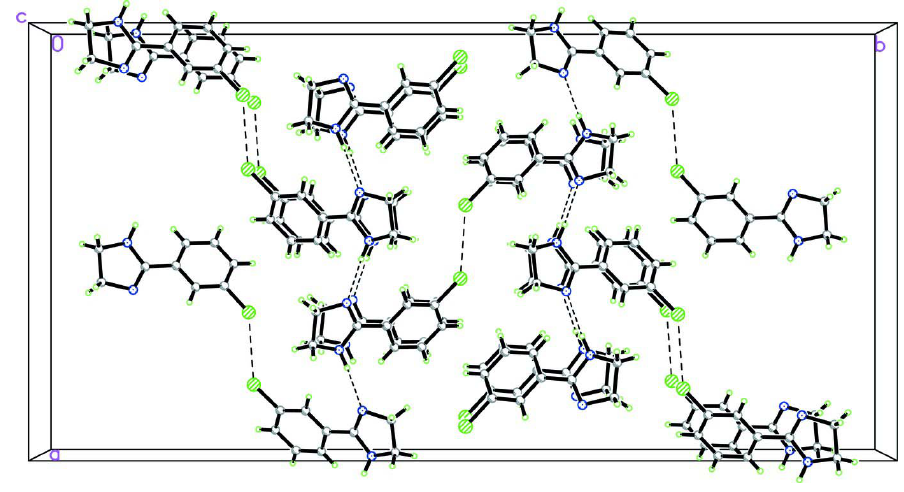
Figure 2 The crystal packing of (I), viewed down the c -axis showing linking of molecules through intermolecular N—H···N hydrogen bonds and short Cl···Cl interactions. The intermolecular interactions are shown as dashed lines. 2-(3-Chlorophenyl)-4,5-dihydro-1 H -imidazole Crystal